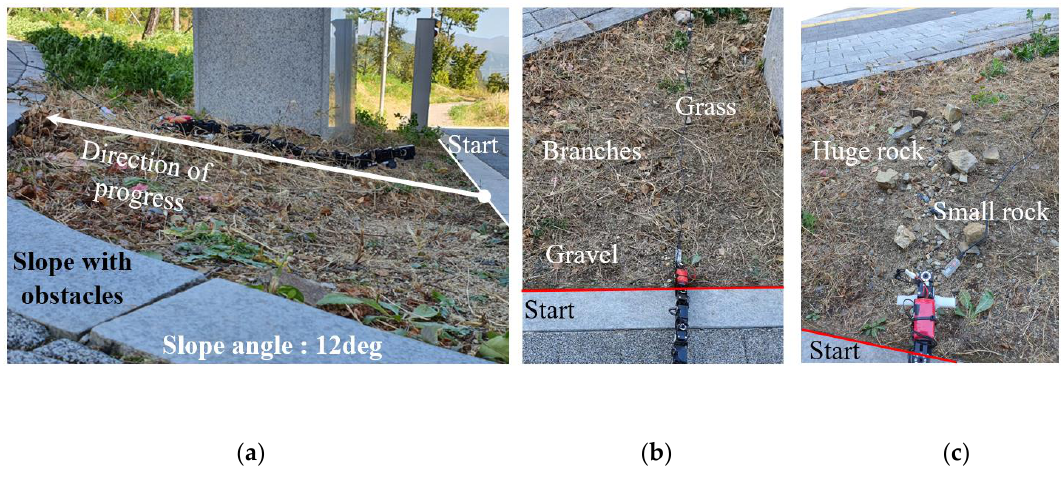
Figure 12. Ascending environments composed of obstacles. ( a ) 12 Degree slope environments. ( b ) The experiments environments which have the grass, branches and gravel. ( c ) The experiments environments which have the small and huge rock.